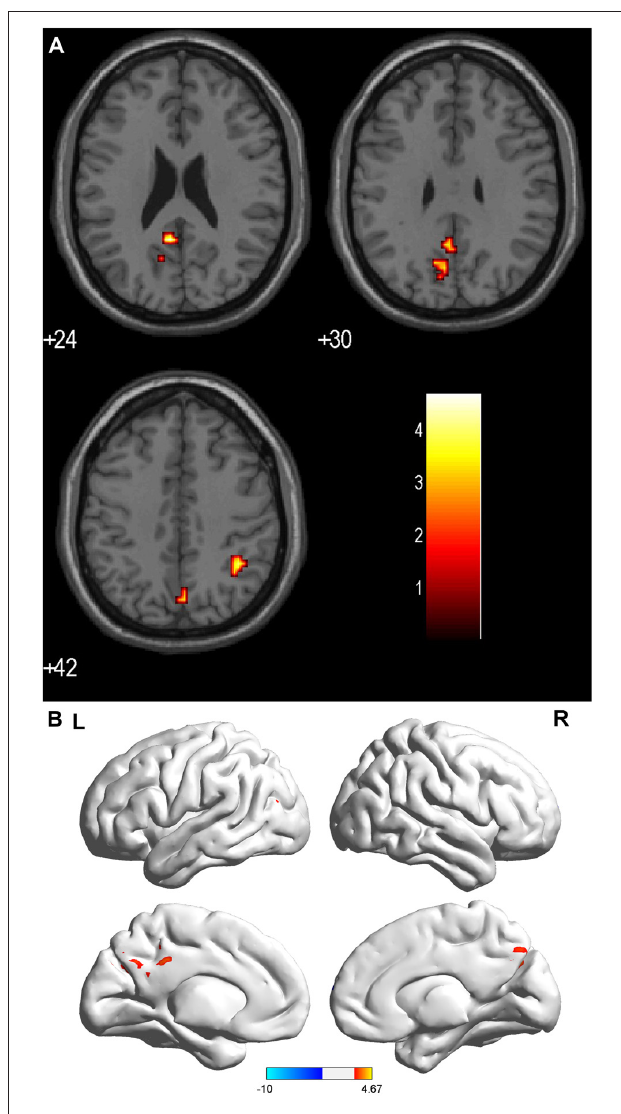
FIGURE 3 | (A,B) ALFF: RED = sON > rON. Brain areas showing significant ALFF differences between the sON and rON patients. Notes: the different brain regions include the right IPL, left posterior cingulate, and bilateral precuneus. The red areas represent lower ALFF brain regions (corrected p < 0.01 using AlphaSim). Abbreviations: ON, optic neuritis; ALFF, amplitude of low-frequency fluctuation; L, left; R, right.